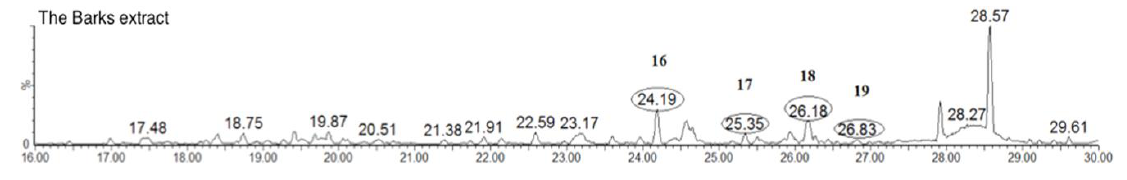
Figure 7. Product ion spectrum and proposed MS fragmentation mechanism of peak 14 in positive mode.